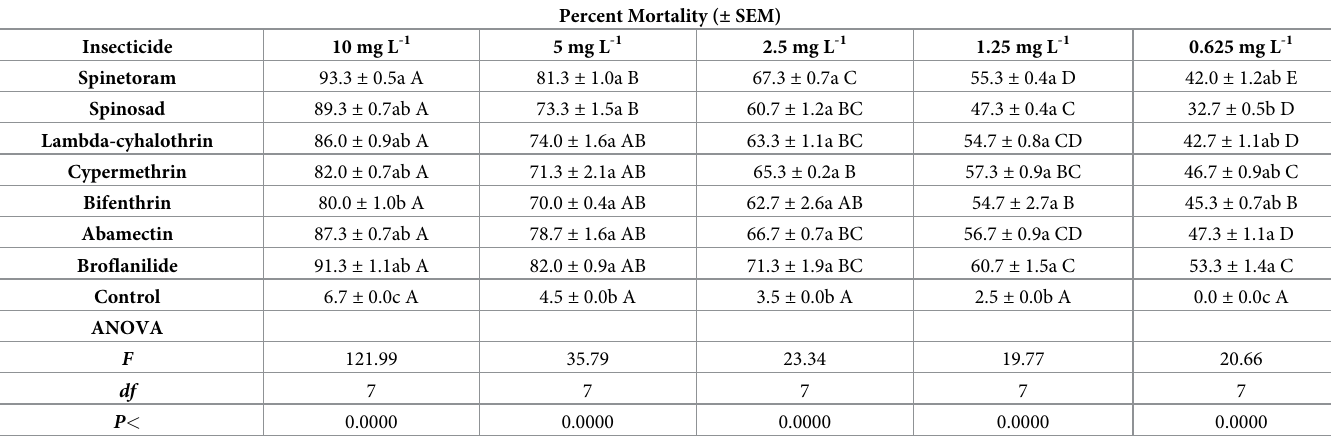
P < 0.0000 Means ± SE within a column of each insecticide and row of each concentration followed by the same letters are not significantly different at P = 0.05 (Tukey’s test). Lower case letters immediately following values represent comparisons within a column and capital letters represent comparisons within a row. Means were calculated from five repetitions each comprising n = 30 larvae.